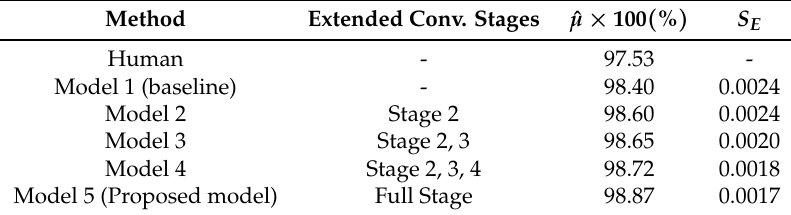
Table 3. Means and standard deviations of matching accuracies on the LFW dataset